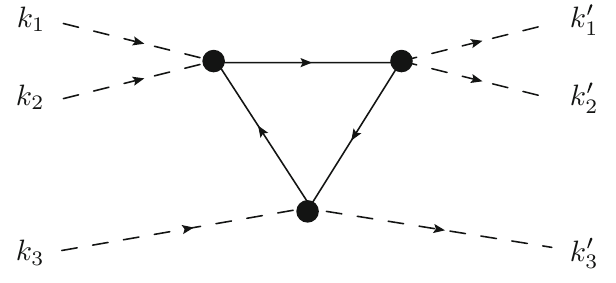
Fig. 3 Set up of the triangle